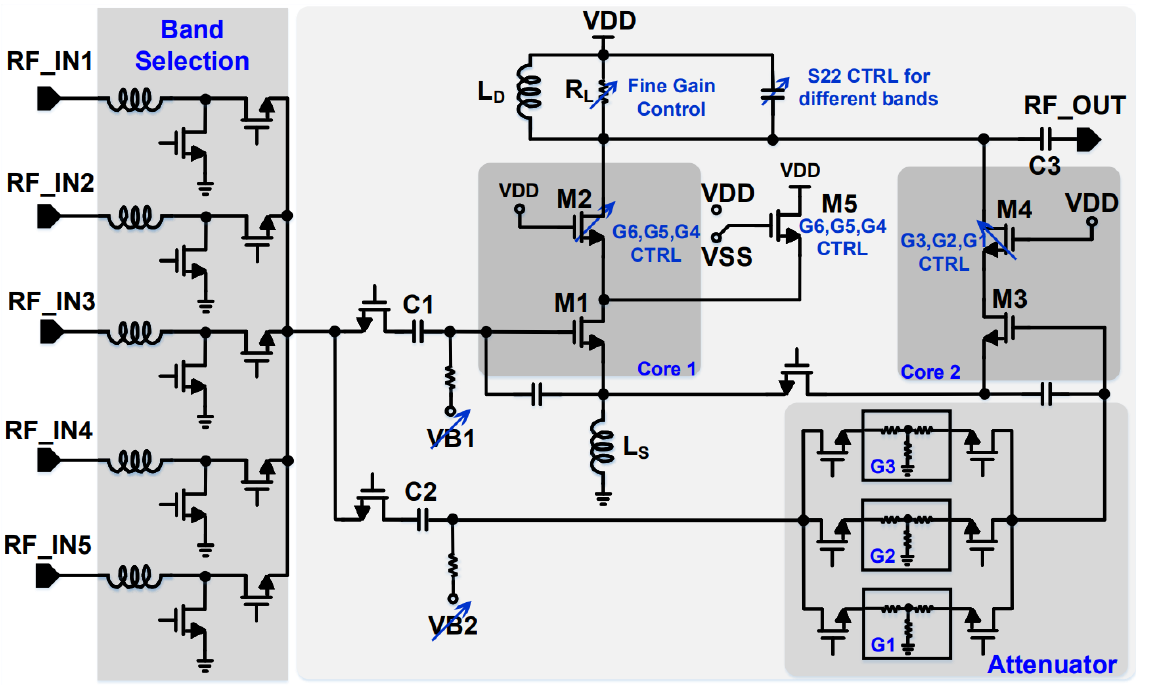
Figure 2. Structure of the designed low band